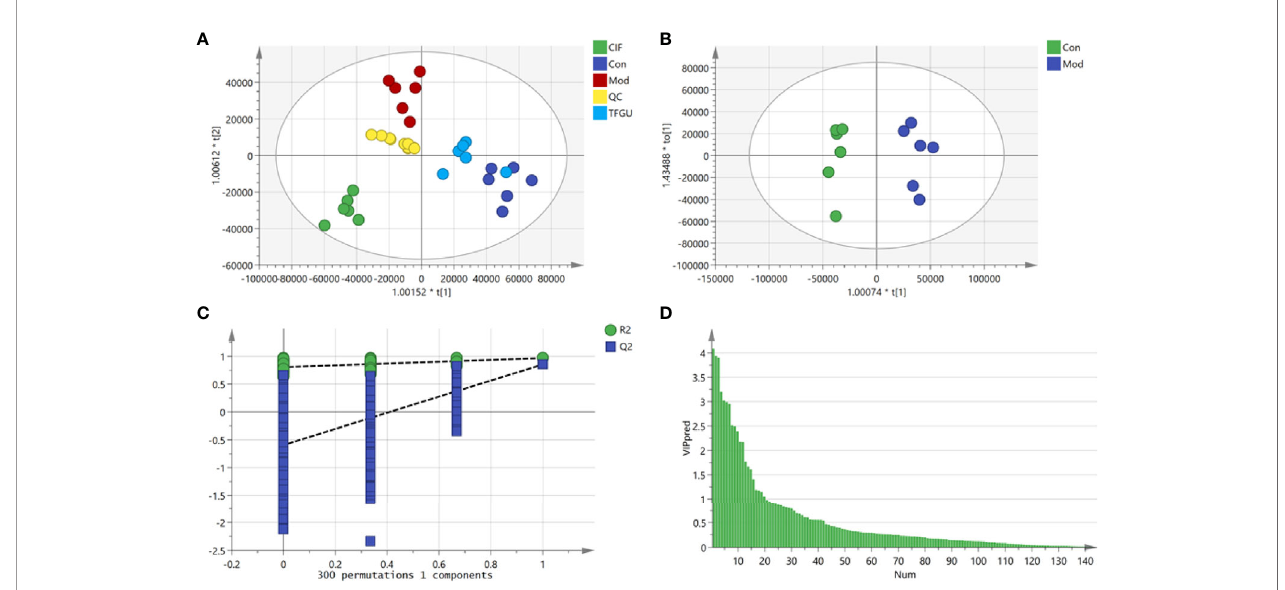
FIGURE 6 | Effects of TFGU on the fecal metabolism in CPT-11 – induced colitis mice. (A) The orthogonal projection to latent structures discriminant analysis (OPLS- DA) score plot of Con, Mod, CIF and TFGU groups and QC samples. (B) The OPLS-DA plot between Con and Mod groups. (C) Three hundred times permutations of OPLS-DA plot between Con and Mod groups. (D) Variable importance in project (VIP) plot between Con and Mod groups at positive mode (n = 6